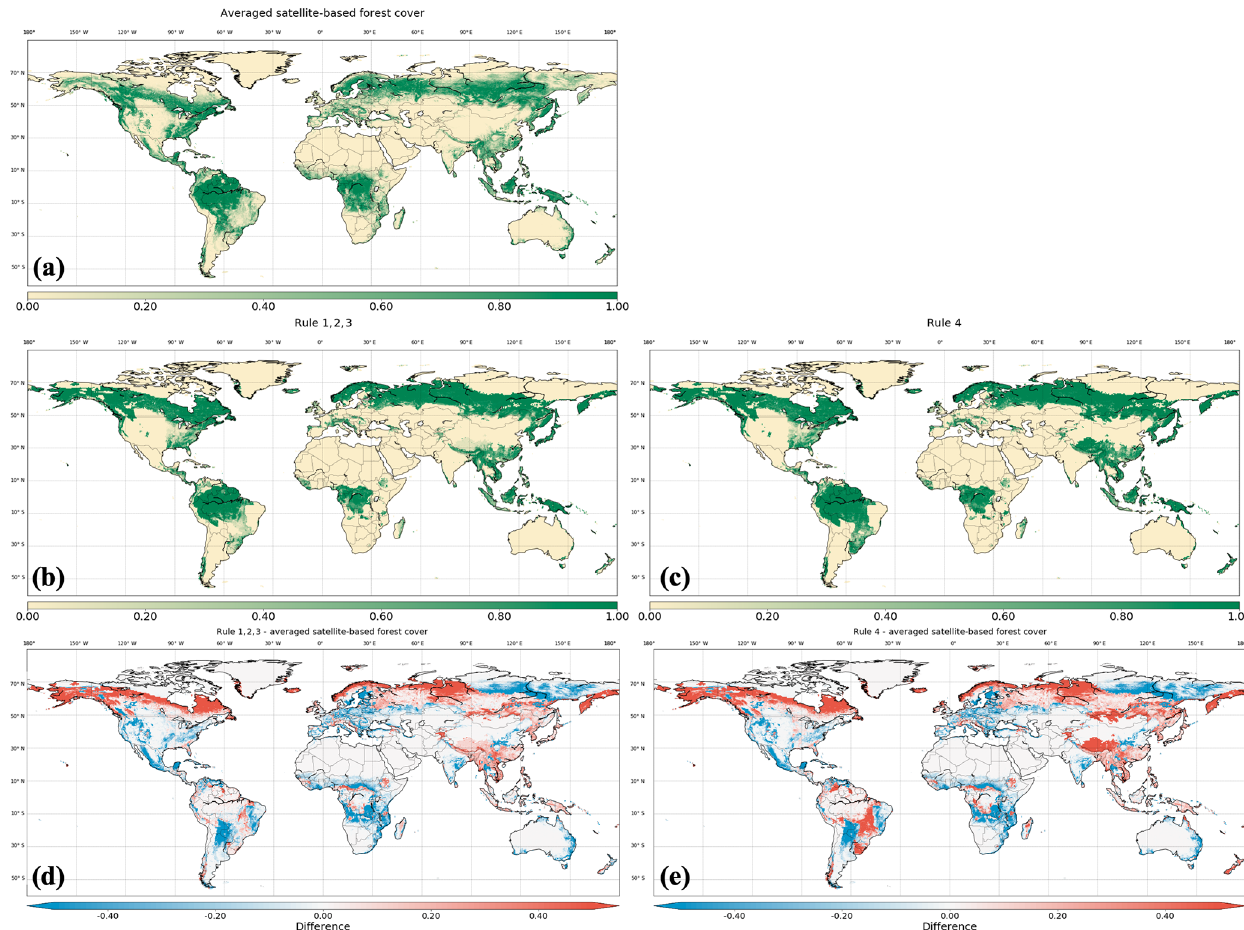
Figure 2. Forest cover in 2000 from the averaged satellite-based forest cover in (a) ; Rule 1, 2, 3 in (b) ; and Rule 4 in (c) . Panels (d) and (e) are maps of forest cover difference between (b) and (a) and (c) and (a) , respectively.